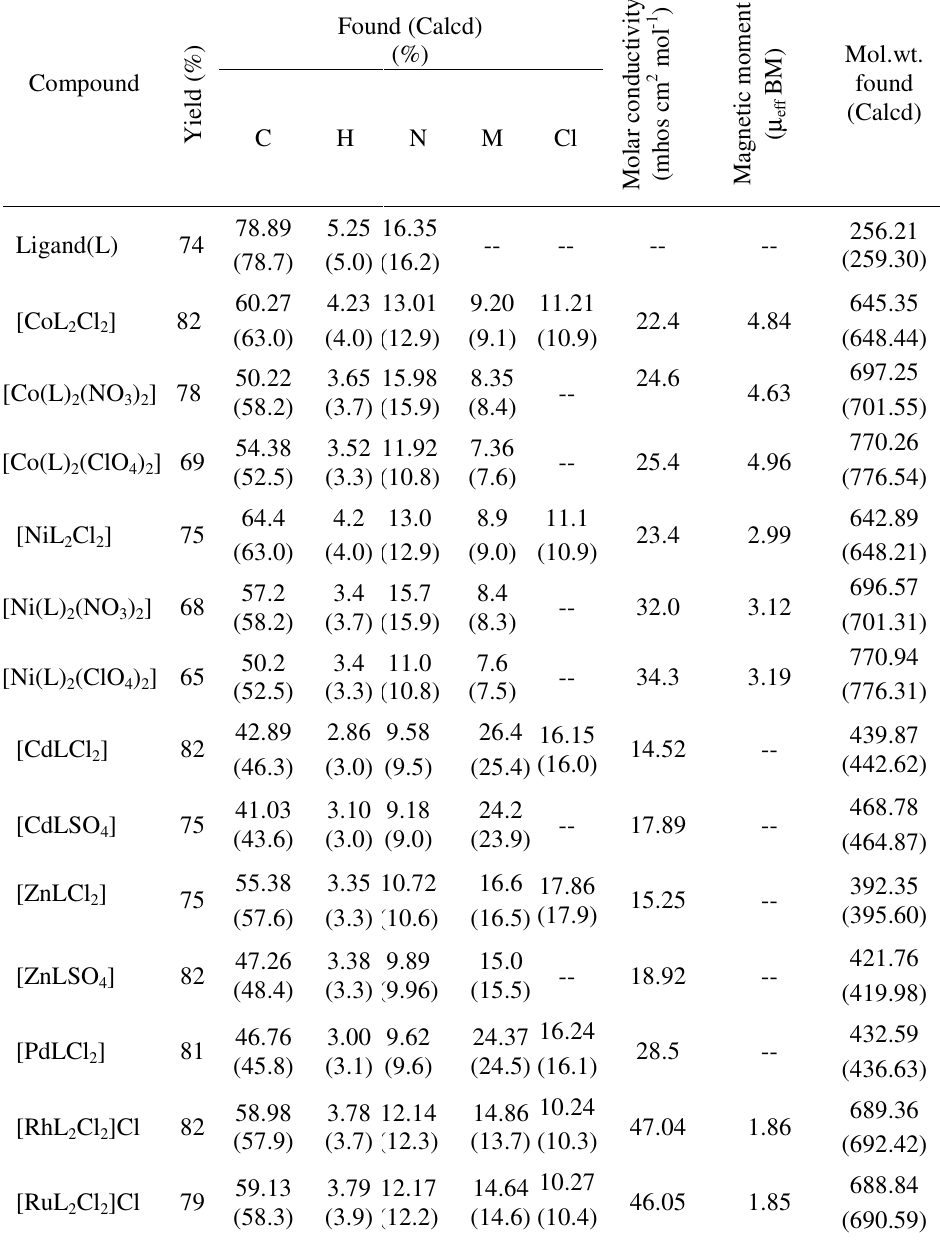
Table 1. Physical constants of ligand and its complexes